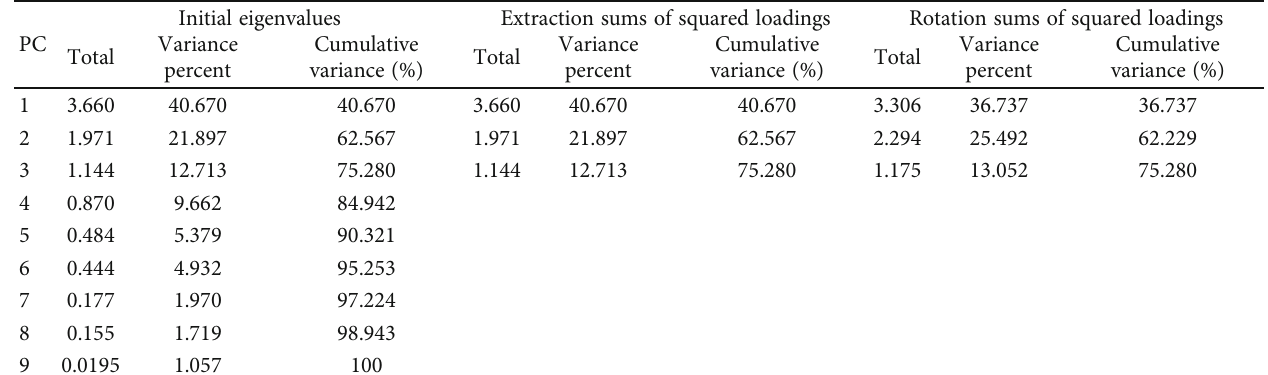
Table 3: Total variances.